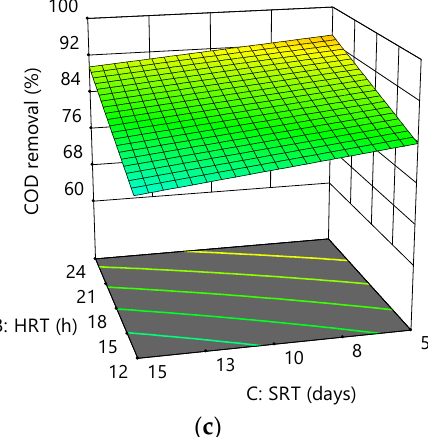
Figure 4. Response surface plots for COD removal efficiency as a function of the following: ( a ) HRT and DO at SRT = 10 days; ( b ) SRT and DO at HRT = 18 h; ( c ) HRT and SRT at DO = 3.5 mg/L. Positive coefficients indicated an increasing effect of A and B on the response, +1.93